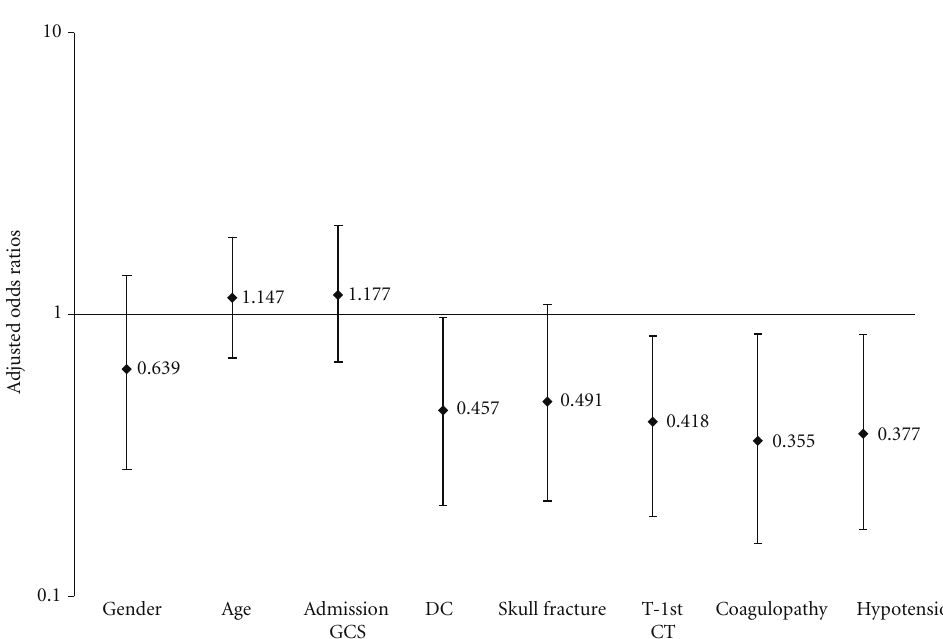
Figure 3: Adjusted odds ratios for PEDH risk factors, where DC is decompressive craniectomy and T-1st CT is time interval from trauma to 1st